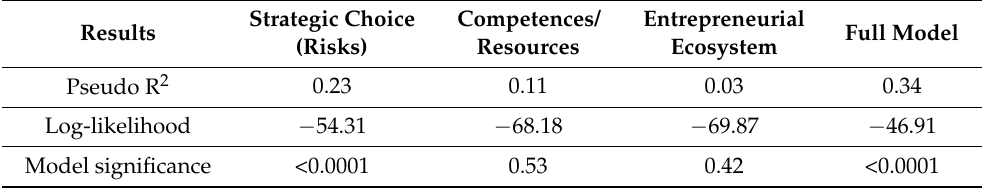
Table A2. Statistical results of the regression